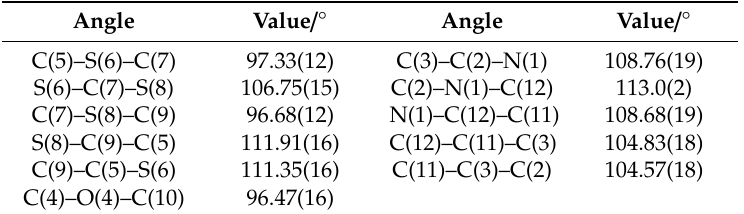
Table 2. Selected